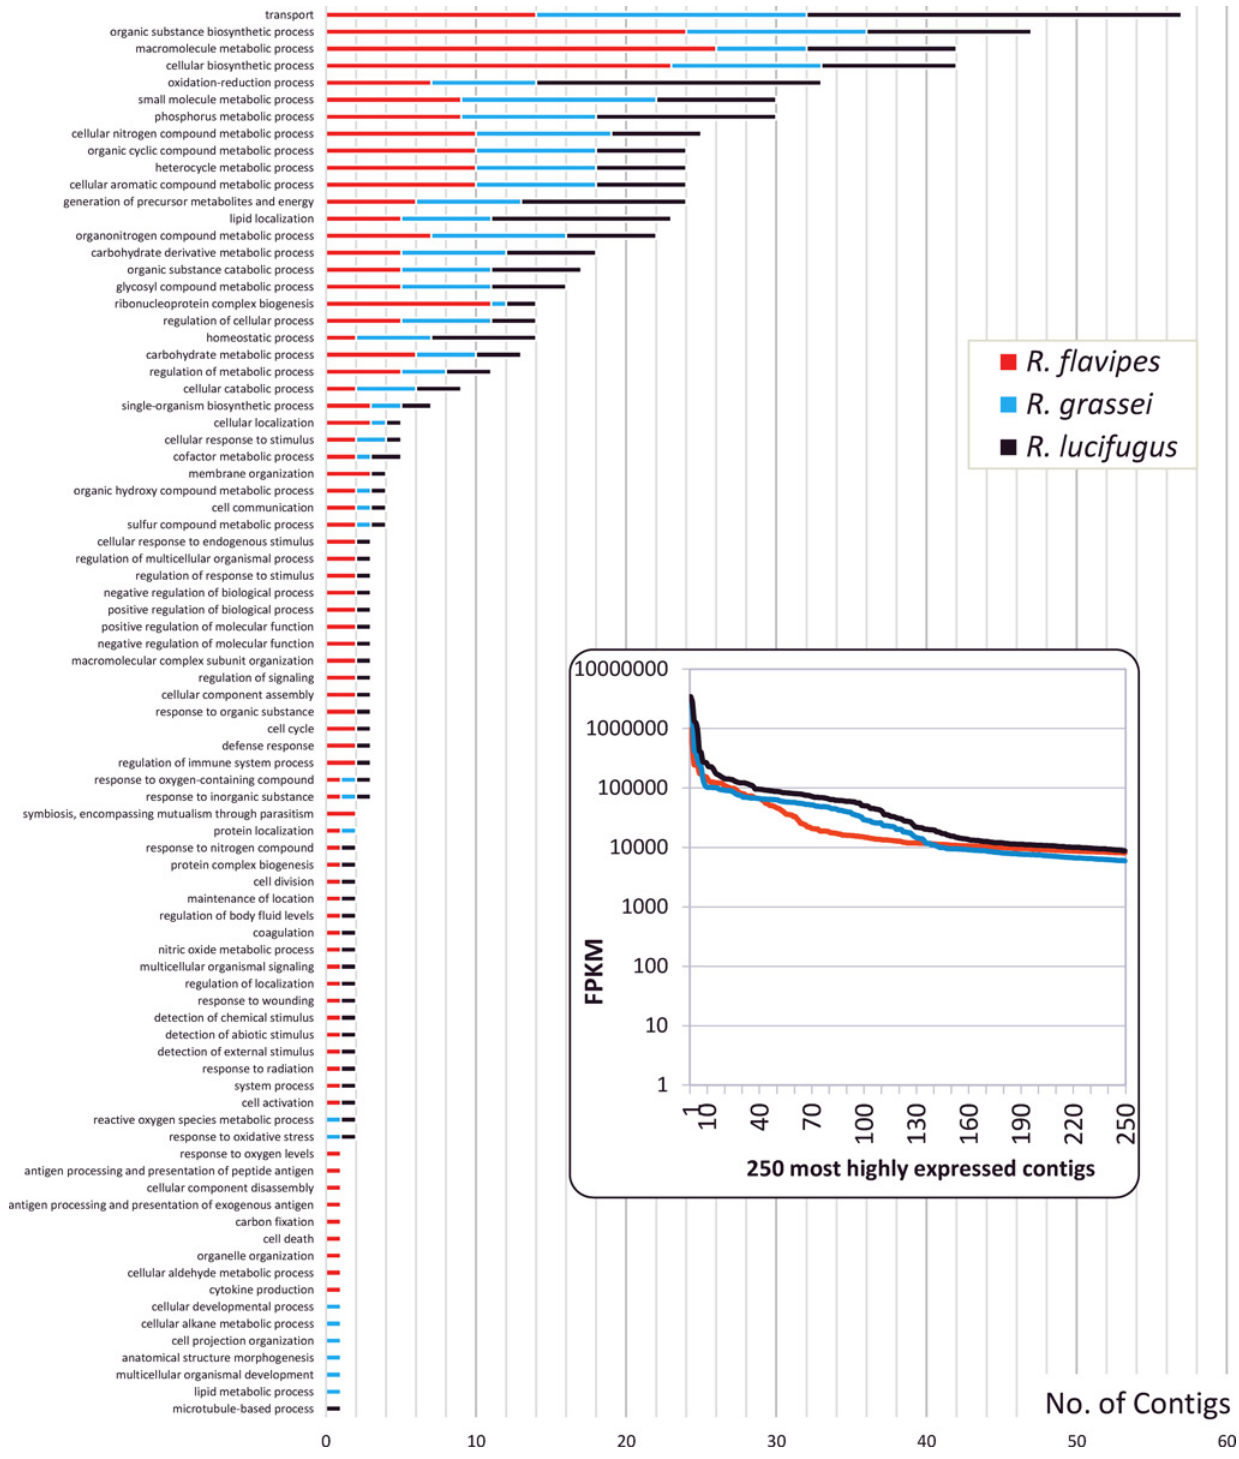
Fig 5. Distribution of the 250 most expressed contigs across their biological functions detected by GO term analysis at the GO level 4. The relative abundance of contigs estimated by FPKM is shown in the box.